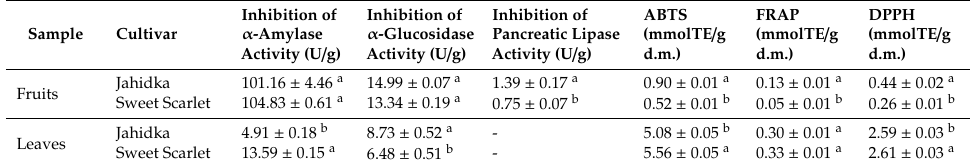
Table 4. Summary of the results obtained for the antioxidant and in vitro biological activities carried out with fruit and leaves of Elaeagnus multiflora